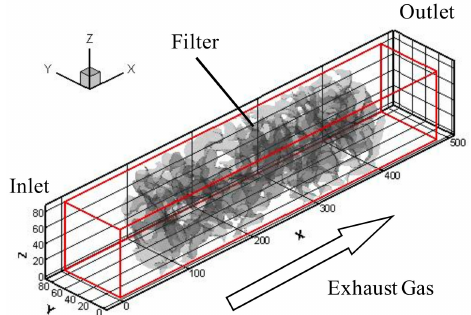
Figure 2. Numerical domain with coordinate with inner substrate structure of sample